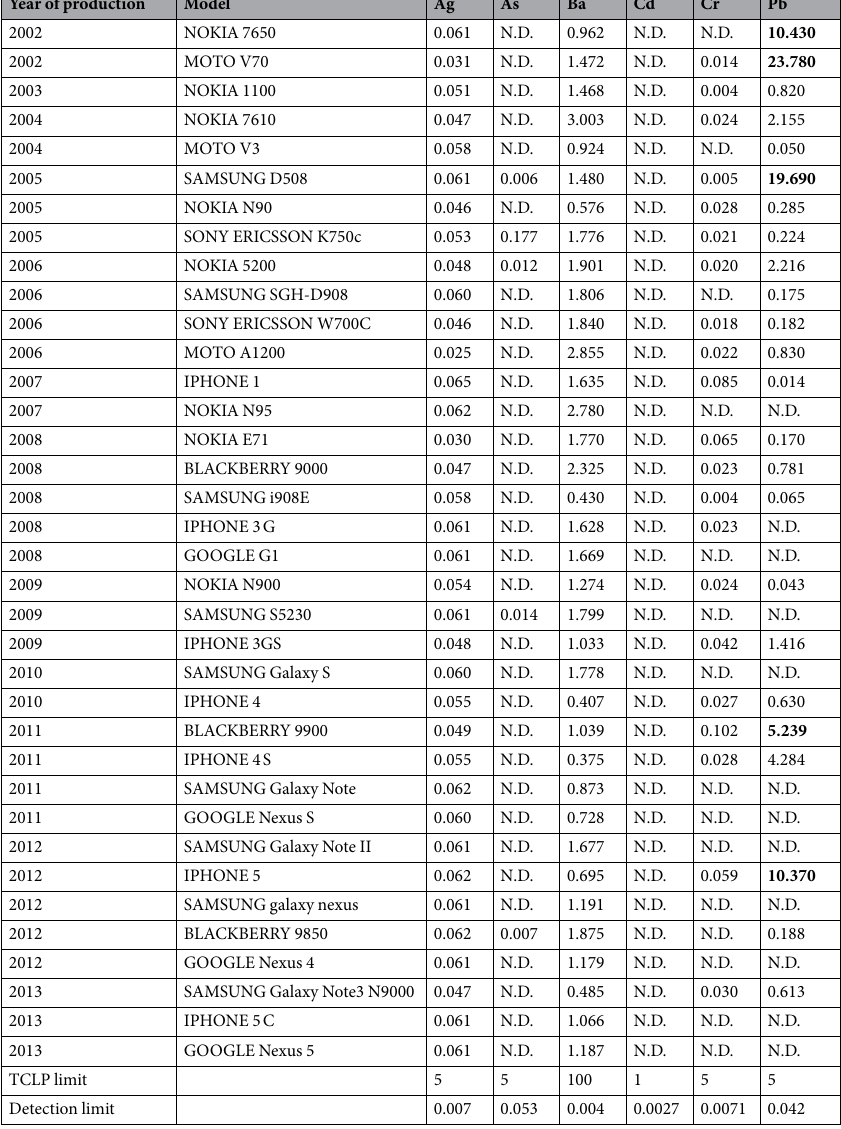
Table 2. Leachates from waste mobile phones according to the Toxicity Characteristics Leaching Procedure (TCLP). Note: N.D.: not detected; concentrations in bold are above regulatory limits; unit of measurement is